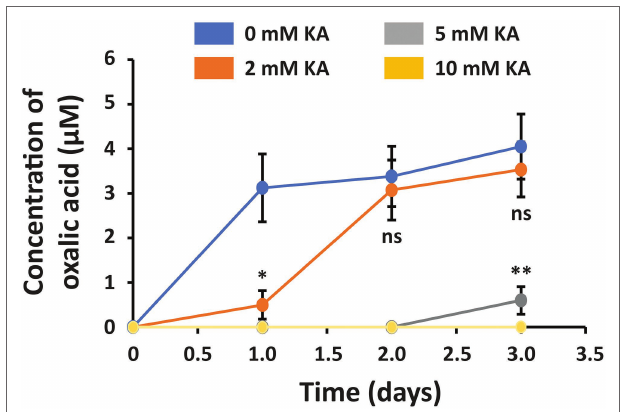
FIGURE 4 | Concentration of oxalic acid in Sclerotinia sclerotiorum secretions after treatment with 2, 5, and 10 mM KA (0.28, 0.71, and 1.42 mg/ ml KA). The control experiment was carried out in the absence of KA. Each treatment mean represents the average of three repetitions. Significance levels at * p < 0.05 and ** p < 0.01. Bars represent the SD.